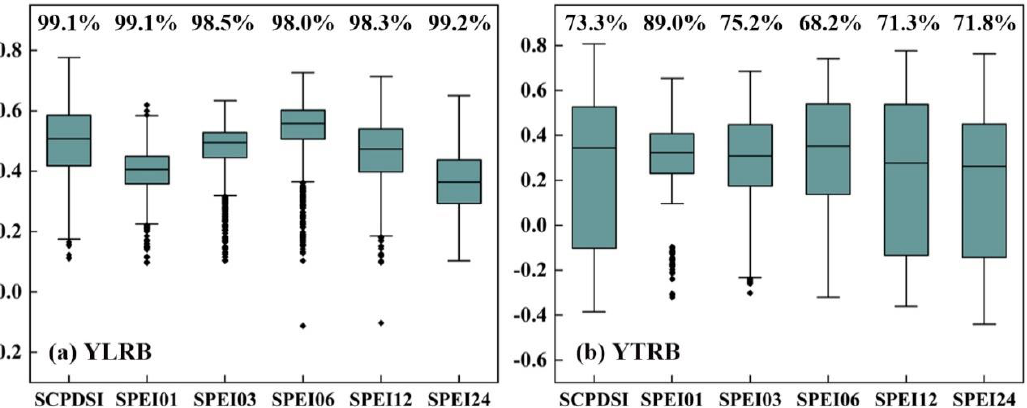
Figure 7. Box and whisker plots show the R-values between SEDI and SCPDSI, SPEI01, SPEI03, SPEI06, SPEI12, and SPEI24 for the entire monthly record ( p < 0.05). The number above the top whisker indicates the percentage of pixels with this correlation of the total pixels in the basin. The thick line in the box represents the median, and the upper and lower parts of the box represent the maximum and minimum values.